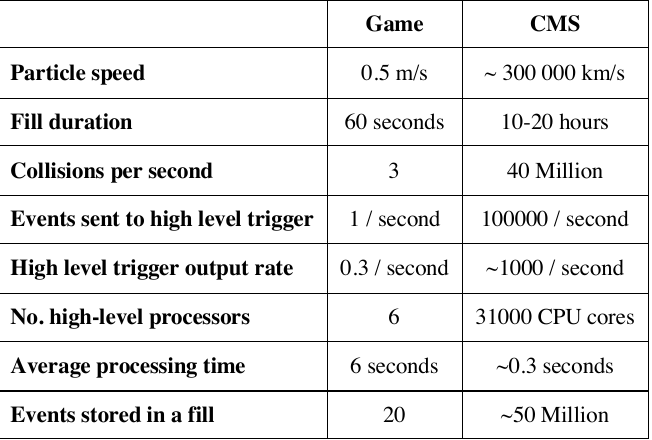
Table 1. Main parameters in the game and in the CMS